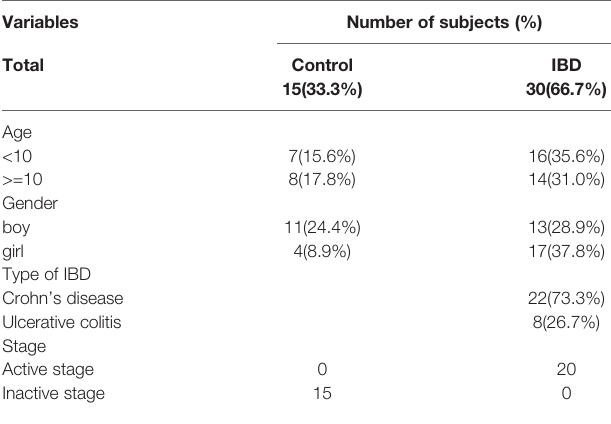
TABLE 1 | The characteristics of subjects enrolled in the study.